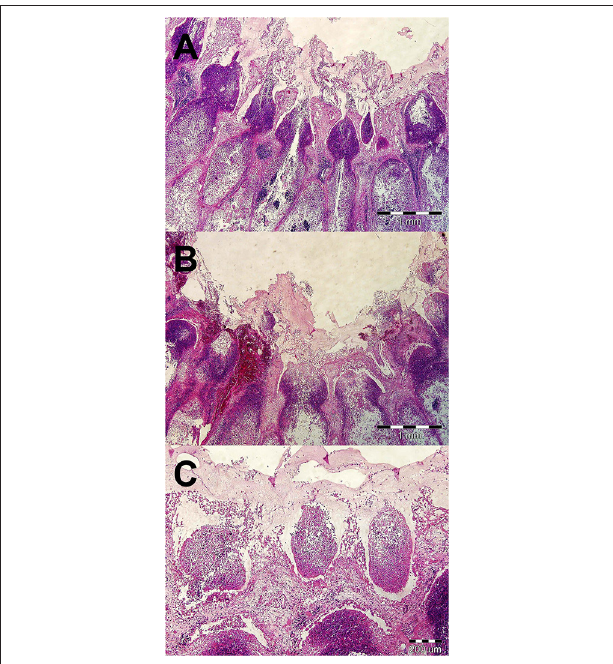
FIGURE 3 | Histopathological examination of a vermiform process in a rabbit with appendicitis (A–C) . (A) Severe oedema of intestinal mucosa, multifocal to diffuse mixed and neutrophilic inflammatory infiltrate, and fibrinous exudate on the surface of mucosa. HE stain, × 40. (B) Areas of haemorrhages in mucosa and superficial fibrinous exudate. HE stain, × 40. (C) Formation of micro-abscesses in superficial part of mainly necrotic mucosa. HE stain, ×